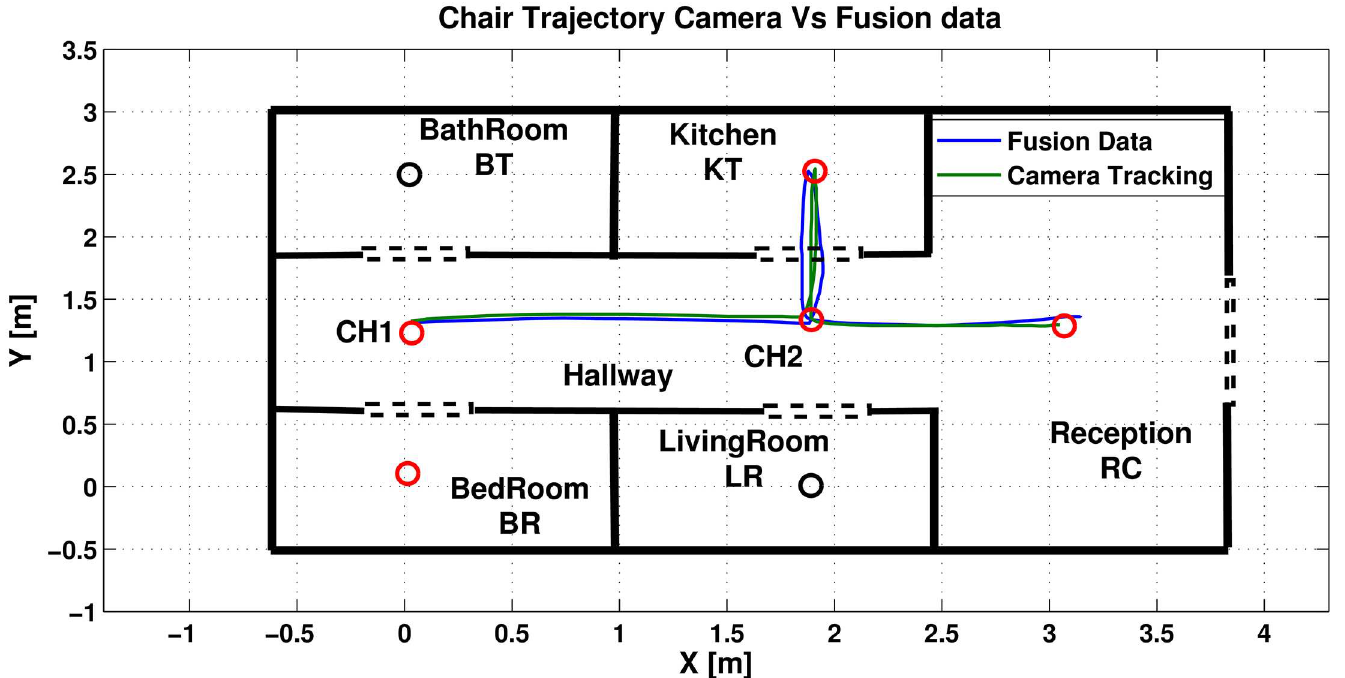
Fig 16. Wheel chair trajectoriesresulted from NAG and camerapositioning